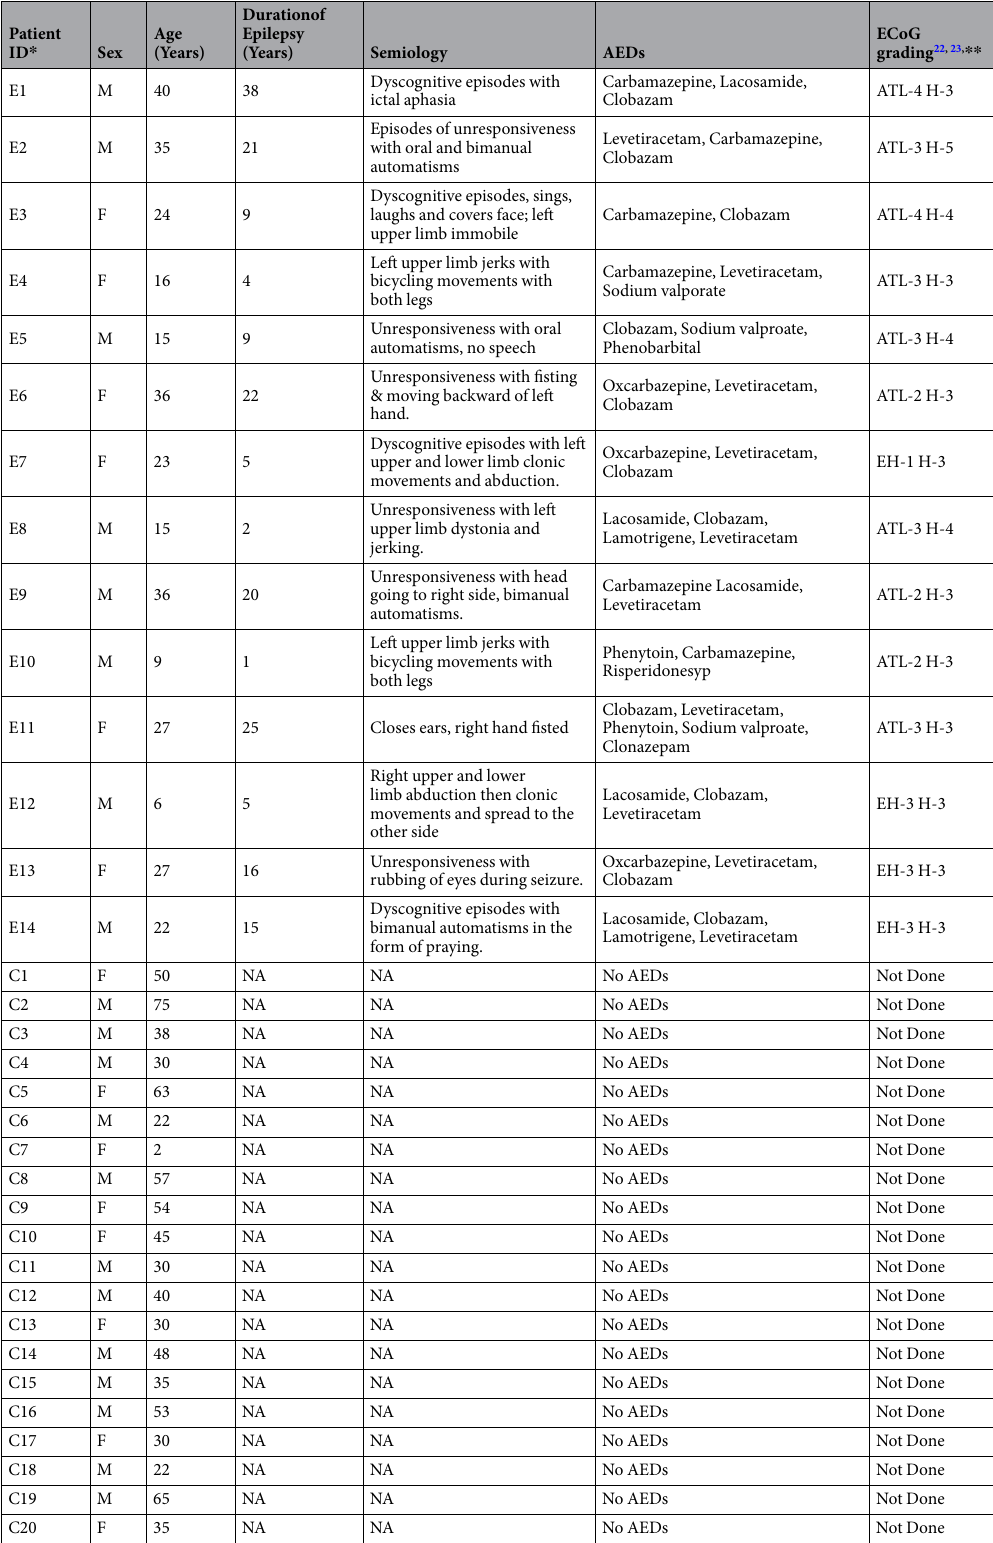
Table 1. Characteristics of patients selected for the study. E1–E14 = Patients with HS. C1–C20 = Patients with glioma (non-seizure controls). * MRI and histo-pathology in all patients showed hippocampal sclerosis. ** EcoG = electro-corticography. NA = Not